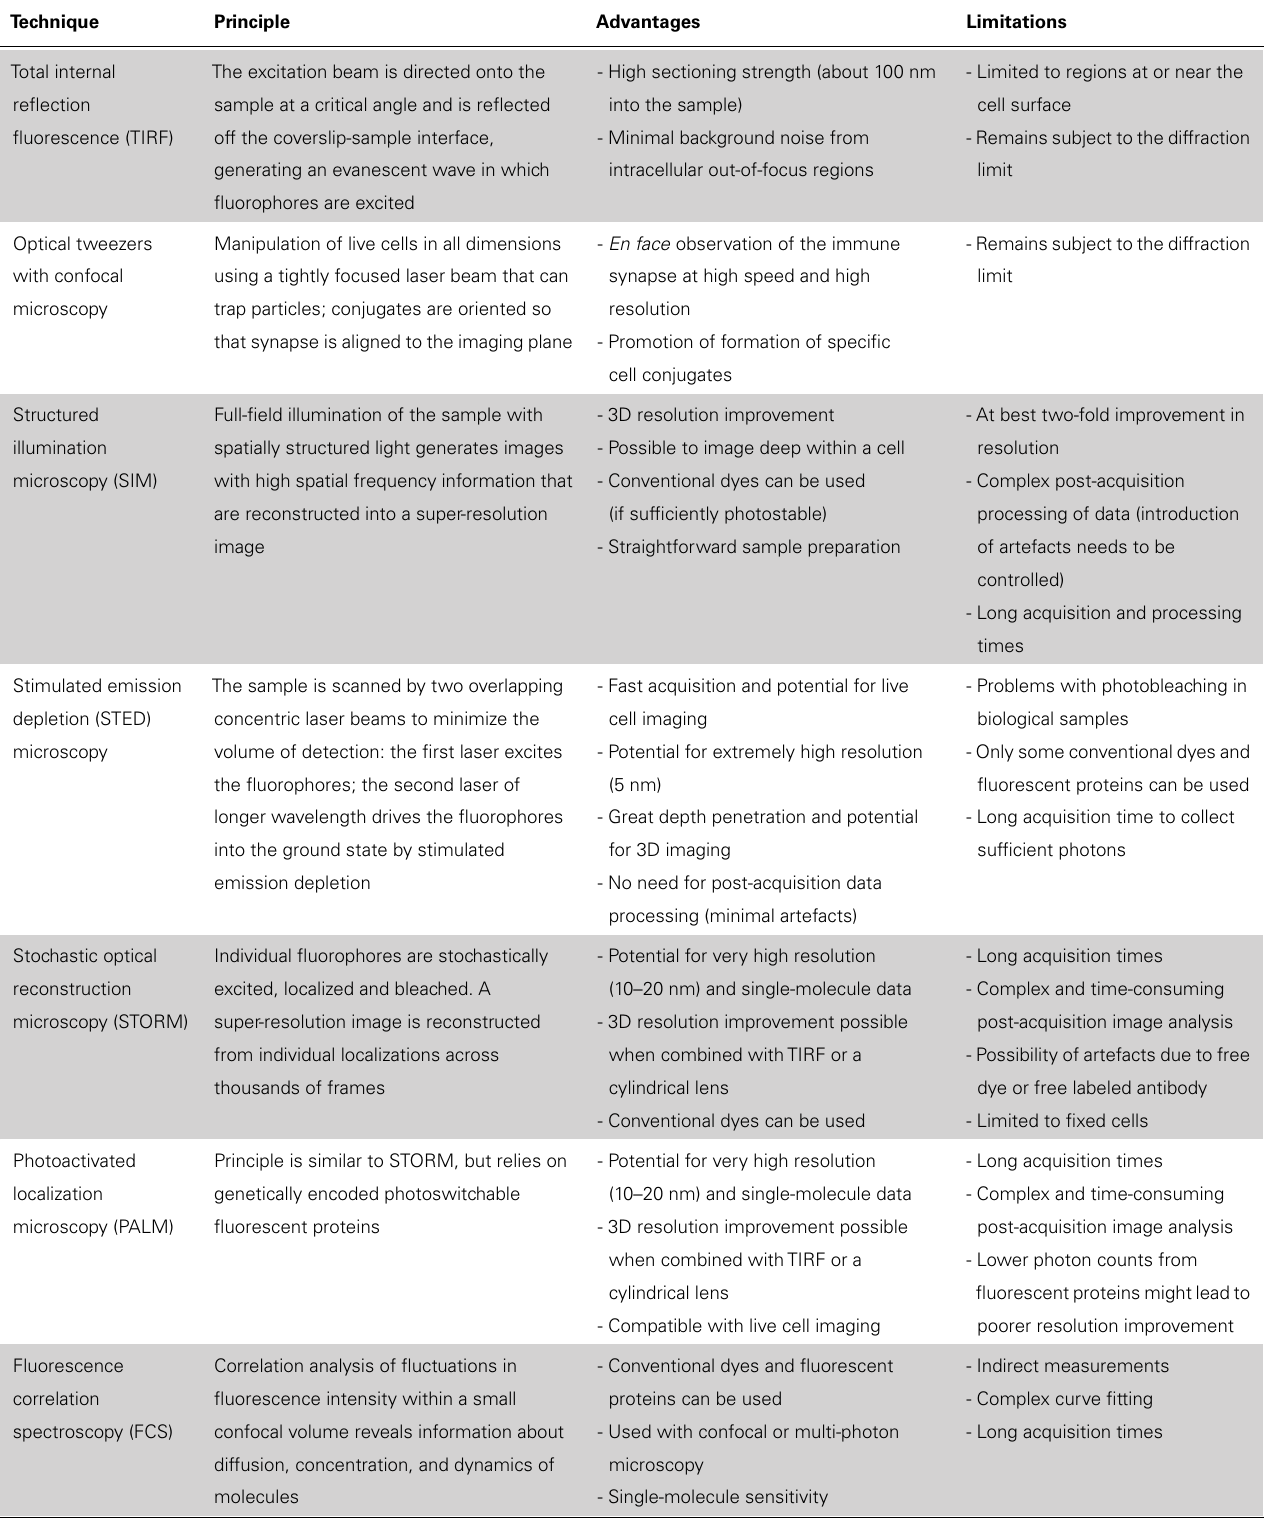
Table 1 | High- and super-resolution techniques for imaging immune synapses at improved resolution.